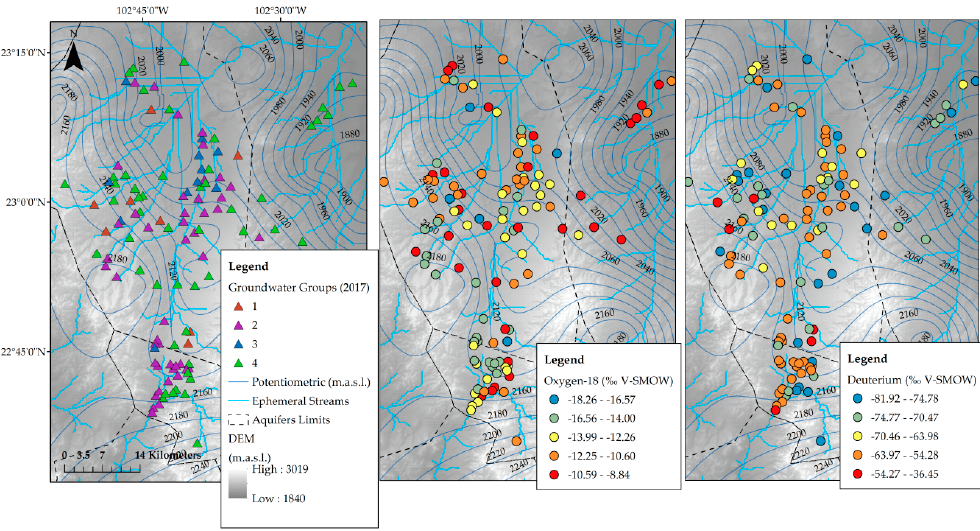
Figure 9. Spatial distribution of the stable isotopic composition of groundwater sampled during 2014– 2015 [7]. 2014–2015